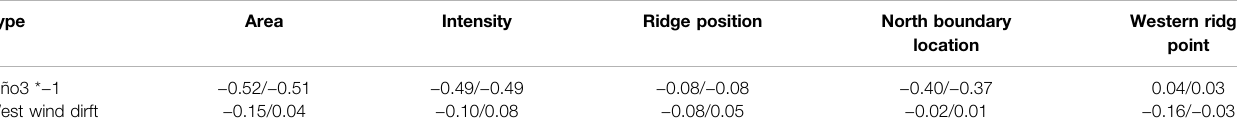
TABLE 2 | Correlation/partial correlation coef fi cients between the SST index and the West Paci fi c Subtropical high index in different key